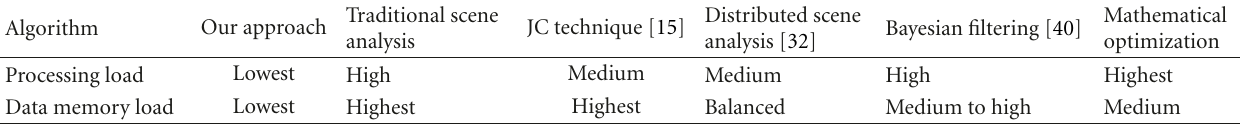
Table 5: Location estimation load comparison.